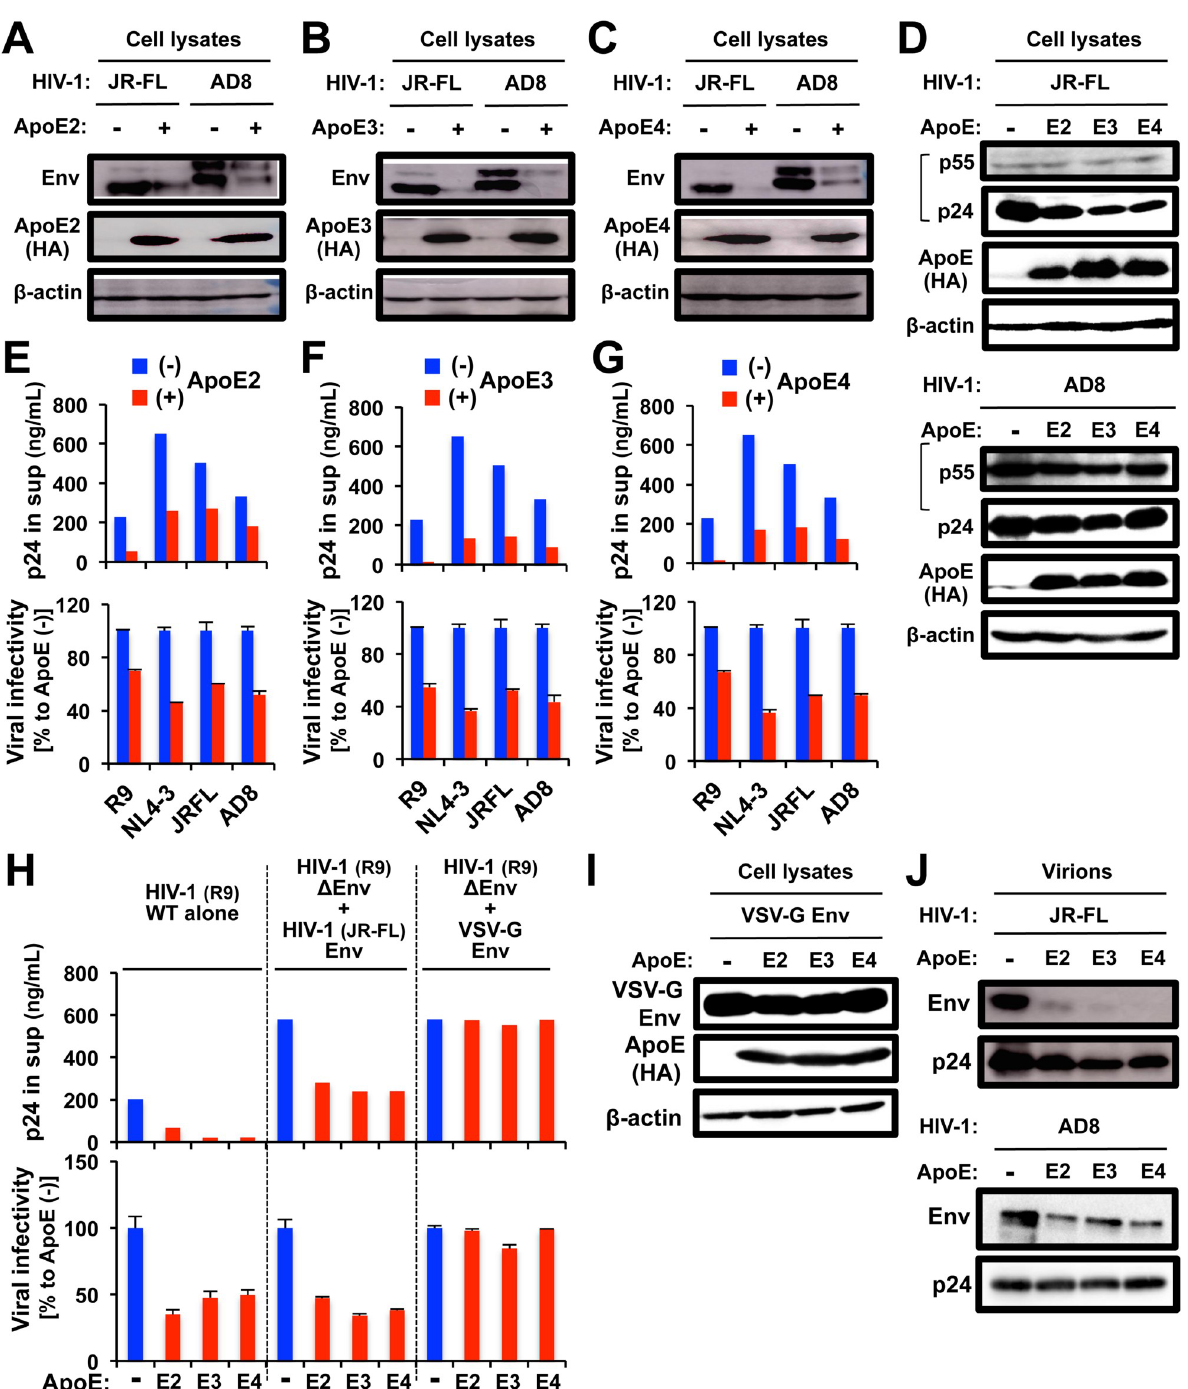
Fig 5. Effects of exogenous expression of ApoE on Env expression and viral infectivity in 293T cells. (A-C) The 293T cells were transfected with 2 μ g of the HIV-1 molecular clone (JR-FL or AD8), or co-transfected with 2 μ g of the indicated HA-tagged ApoE expression vector, cultured for 3 days, lysed, and subjected to western blot to analyze the expression of Env. ApoE expression was verified using anti-HA antibody. Anti- β -actin blot was used as a loading control. (D) The 293T cells were transfected with 2 μ g of the HIV-1 molecular clone (JR-FL in upper panel, and AD8 in lower panel), or co-transfected with 2 μ g of the indicated HA-tagged ApoE expression vector, cultured for 3 days, lysed, and subjected to western blot to analyze the expression of Gag (p55 and p24). (E-G) The 293T cells were transfected with 2 μ g of the HIV-1 molecular clone (R9, NL4-3, JR-FL or AD8), or co-transfected with 2 μ g of the indicated HA-tagged ApoE expression vector. The supernatants of the transfected 293T cells were collected and analyzed for their levels of p24 concentration by ELISA (upper panels). Then, viruses (input p24: 10 ng/mL) were added to TZM-bl indicator